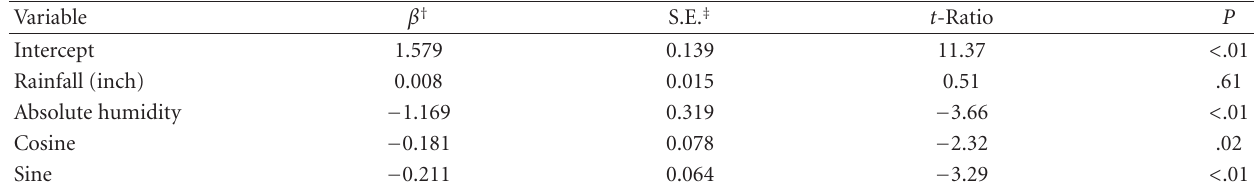
Table 2: Monthly weather patterns and the e ff ective reproduction number of smallpox in Northwest frontier province, India, from 1890– 1921.